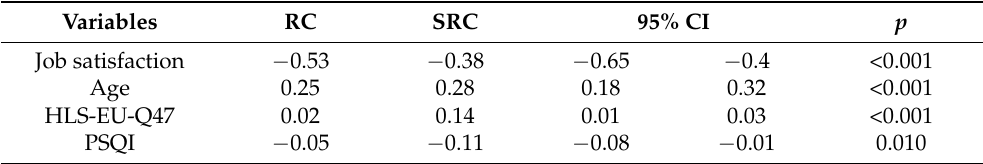
Table 4. Stepwise multiple regression analysis for Work